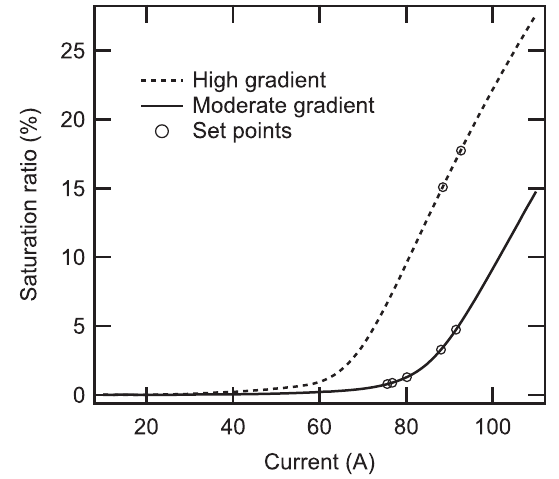
FIG. 3. Magnetic saturation ratio S for the ESRF-EBS quadru- poles. The circles indicate the operation settings. The maximum field gradients are 52 . 8 T = m at 91.5 A for the moderate gradient magnets and 91 . 1 T = m at 92 A for high gradient magnets. The moderate gradient quadrupoles have a 32.8 mm bore diameter and are built with 1400-100 iron-silicon laminations, while the high gradient quadrupoles have a 25.4 mm bore diameter and are made of bulk AISI-1006 low carbon steel parts